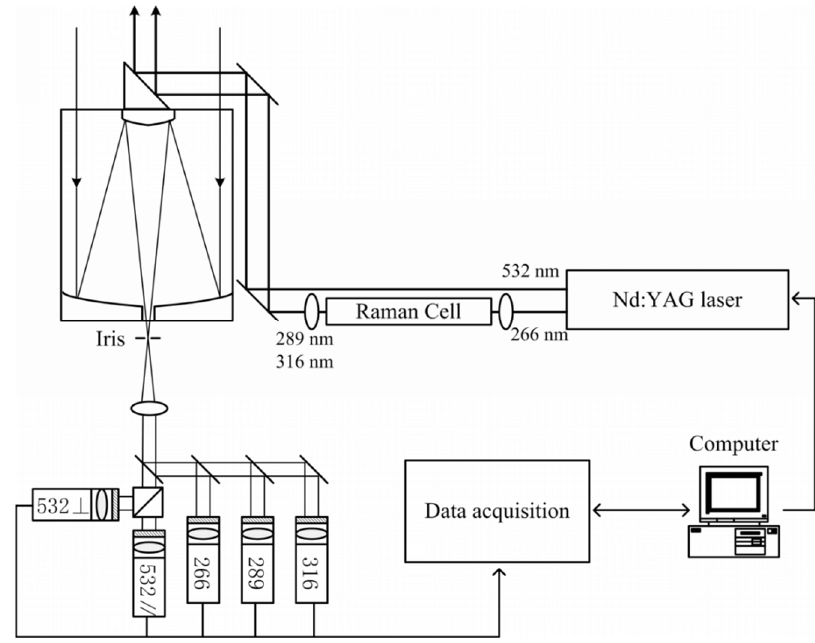
Figure 1. Schematic diagram of the Lidar system.